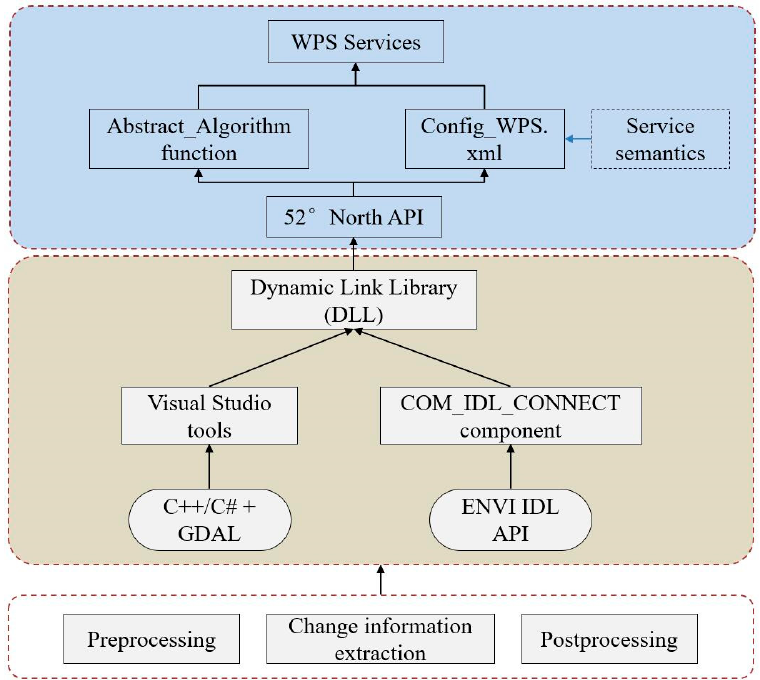
Figure 4. Implementation of web processing service (WPS) service encapsulation from geoprocessing algorithms.